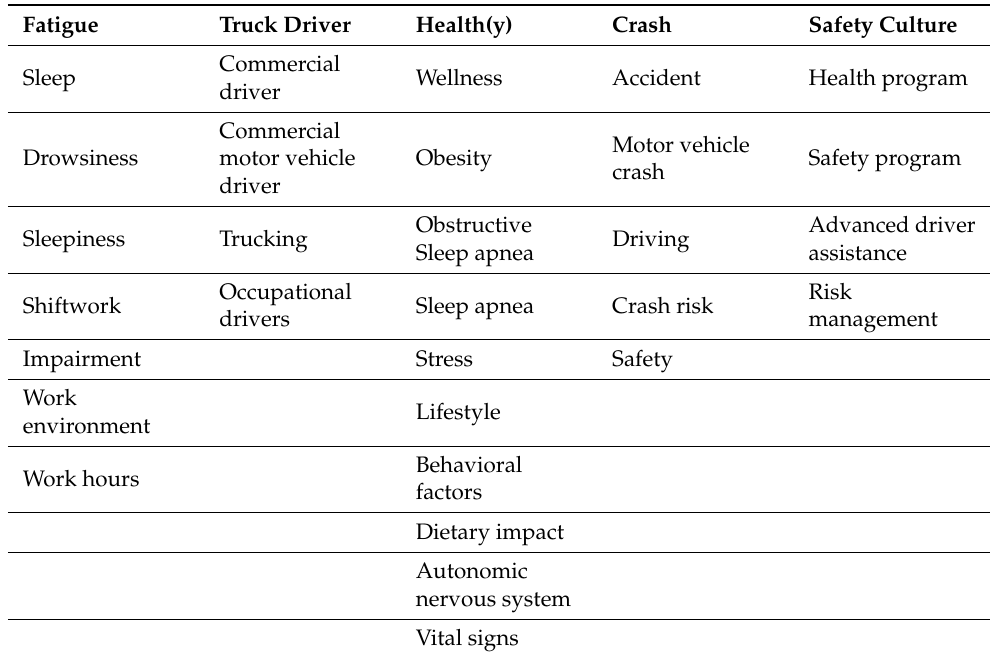
Table 1. Keywords and search terms used in narrative